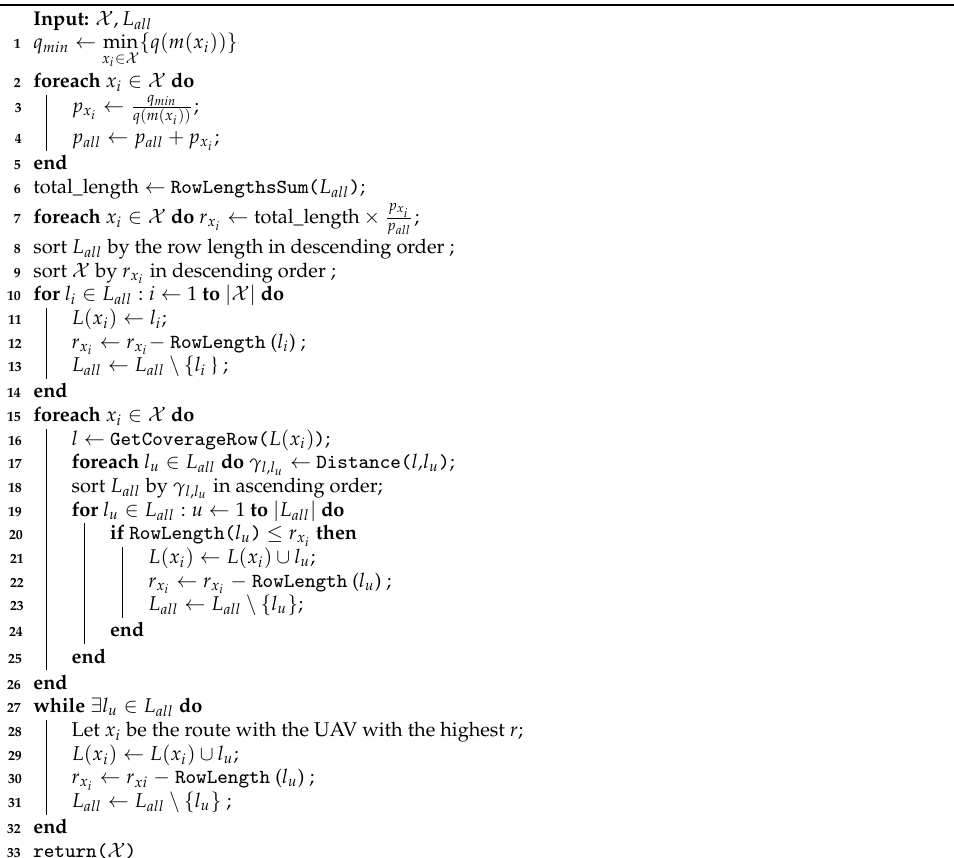
Algorithm 2: Coverage rows